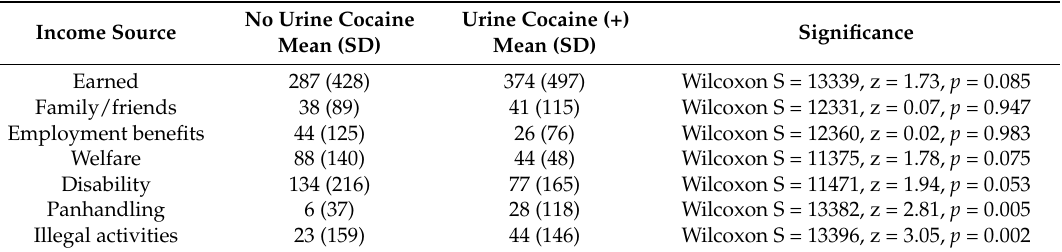
Table 3. Total amounts earned from 30-day income sources across three interviews among those with and without a positive urine cocaine test at any time point.